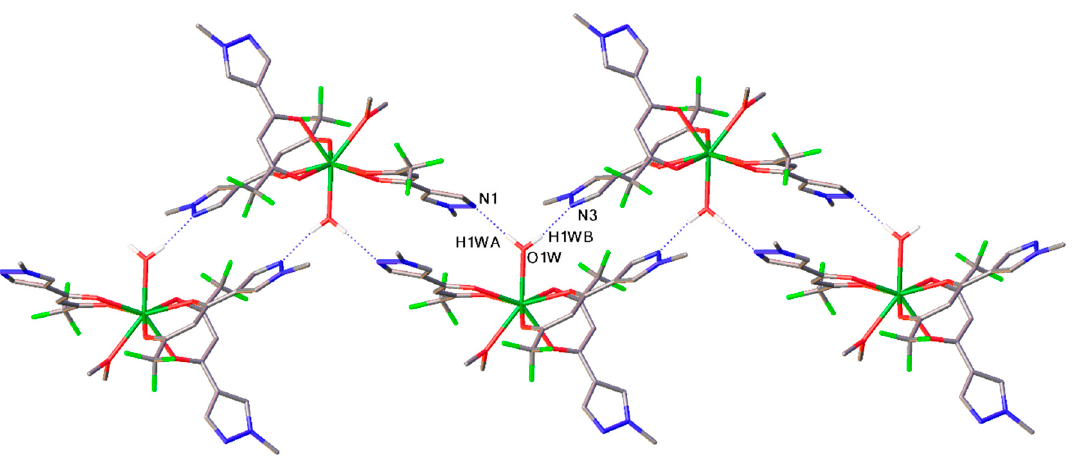
Figure 4 . Fragment of crystal packing of 2 . Hydrogen O-H…N bonds are presented as dotted lines.